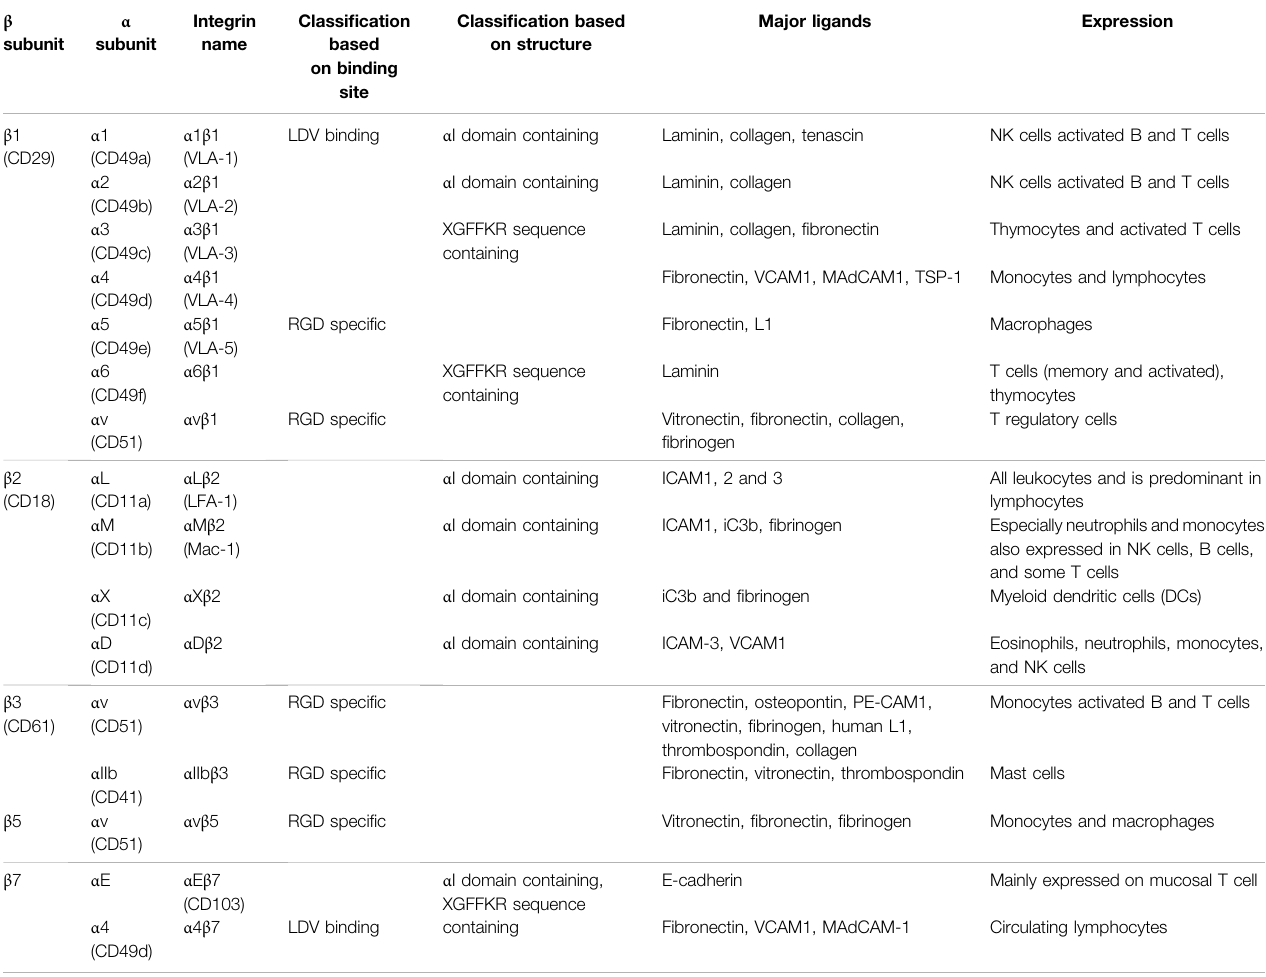
TABLE 1 | Classi fi cation of major integrin with a cluster of differentiation (CD)